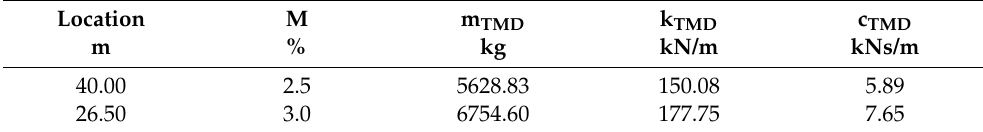
Table 3. TMD parameters for the two different positions are considered in this